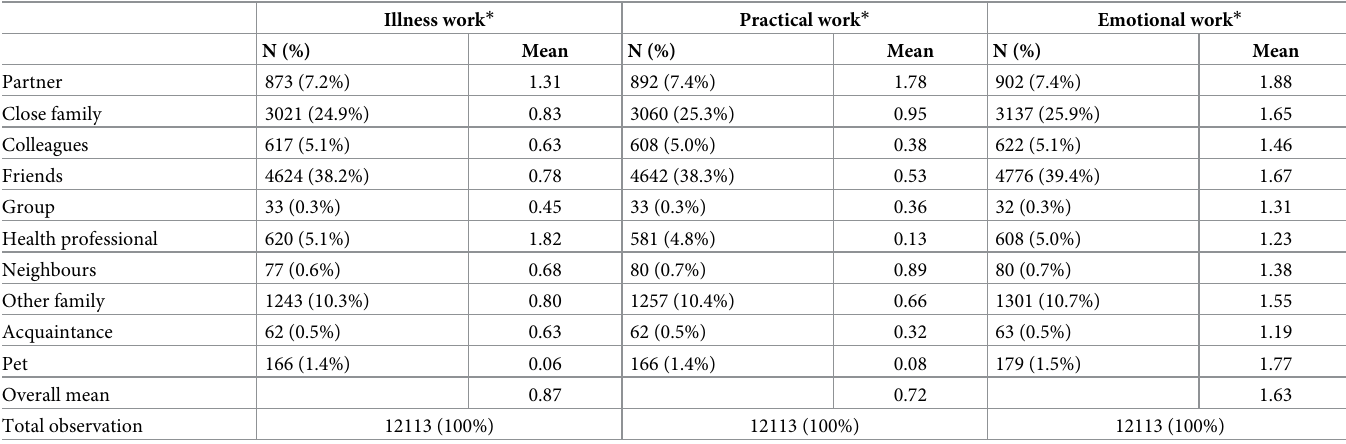
Table 2. Illness, practical and emotional work scores by relationship